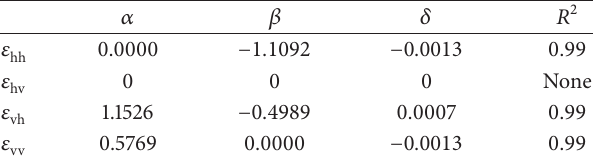
Table 3: The model parameters of a pair of crossed dipoles in the beam direction (60 ∘ , 45 ∘